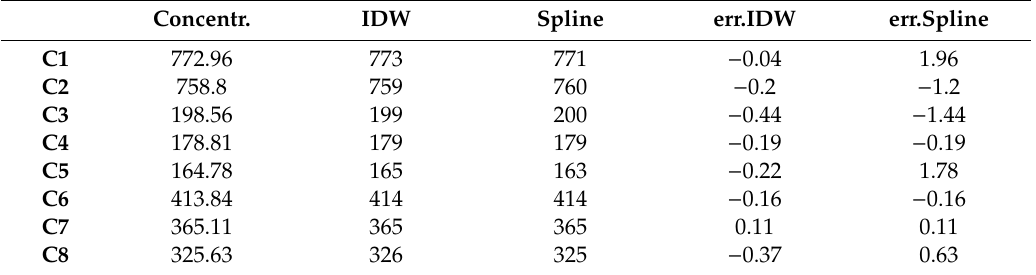
Table 4. Interpolation error analysis.